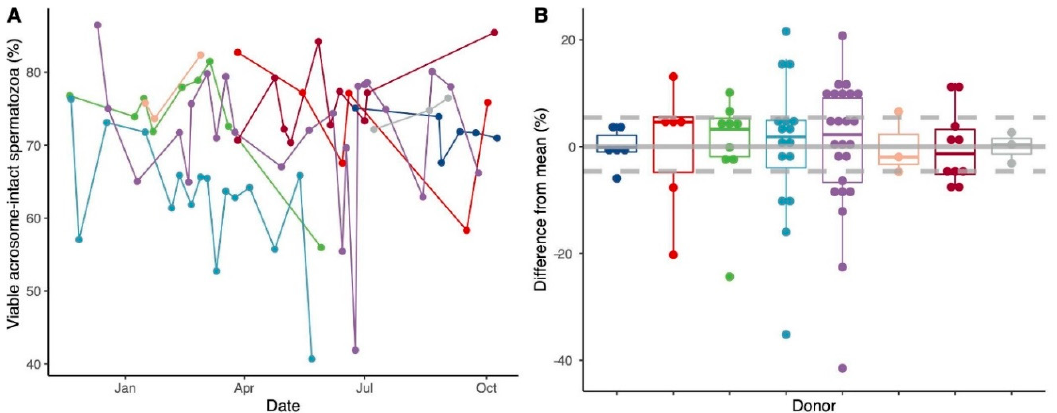
Figure 3. Intra-individual variation of acrosomal status in raw ejaculates of donors analyzed over time ( A ) Acrosomal status in repeated samples over time from eight donors (indicated by eight different colors). ( B ) The intra-individual variation is shown as a deviation (%) from the mean for each donor (depicted by the same colors). The boxplots depict the median and interquartile ranges, and the whiskers mark 1.5 × the interquartile range. The average interquartile range of % deviation for all donors ( − 4.6% to 5.5%) is marked by dashed lines .